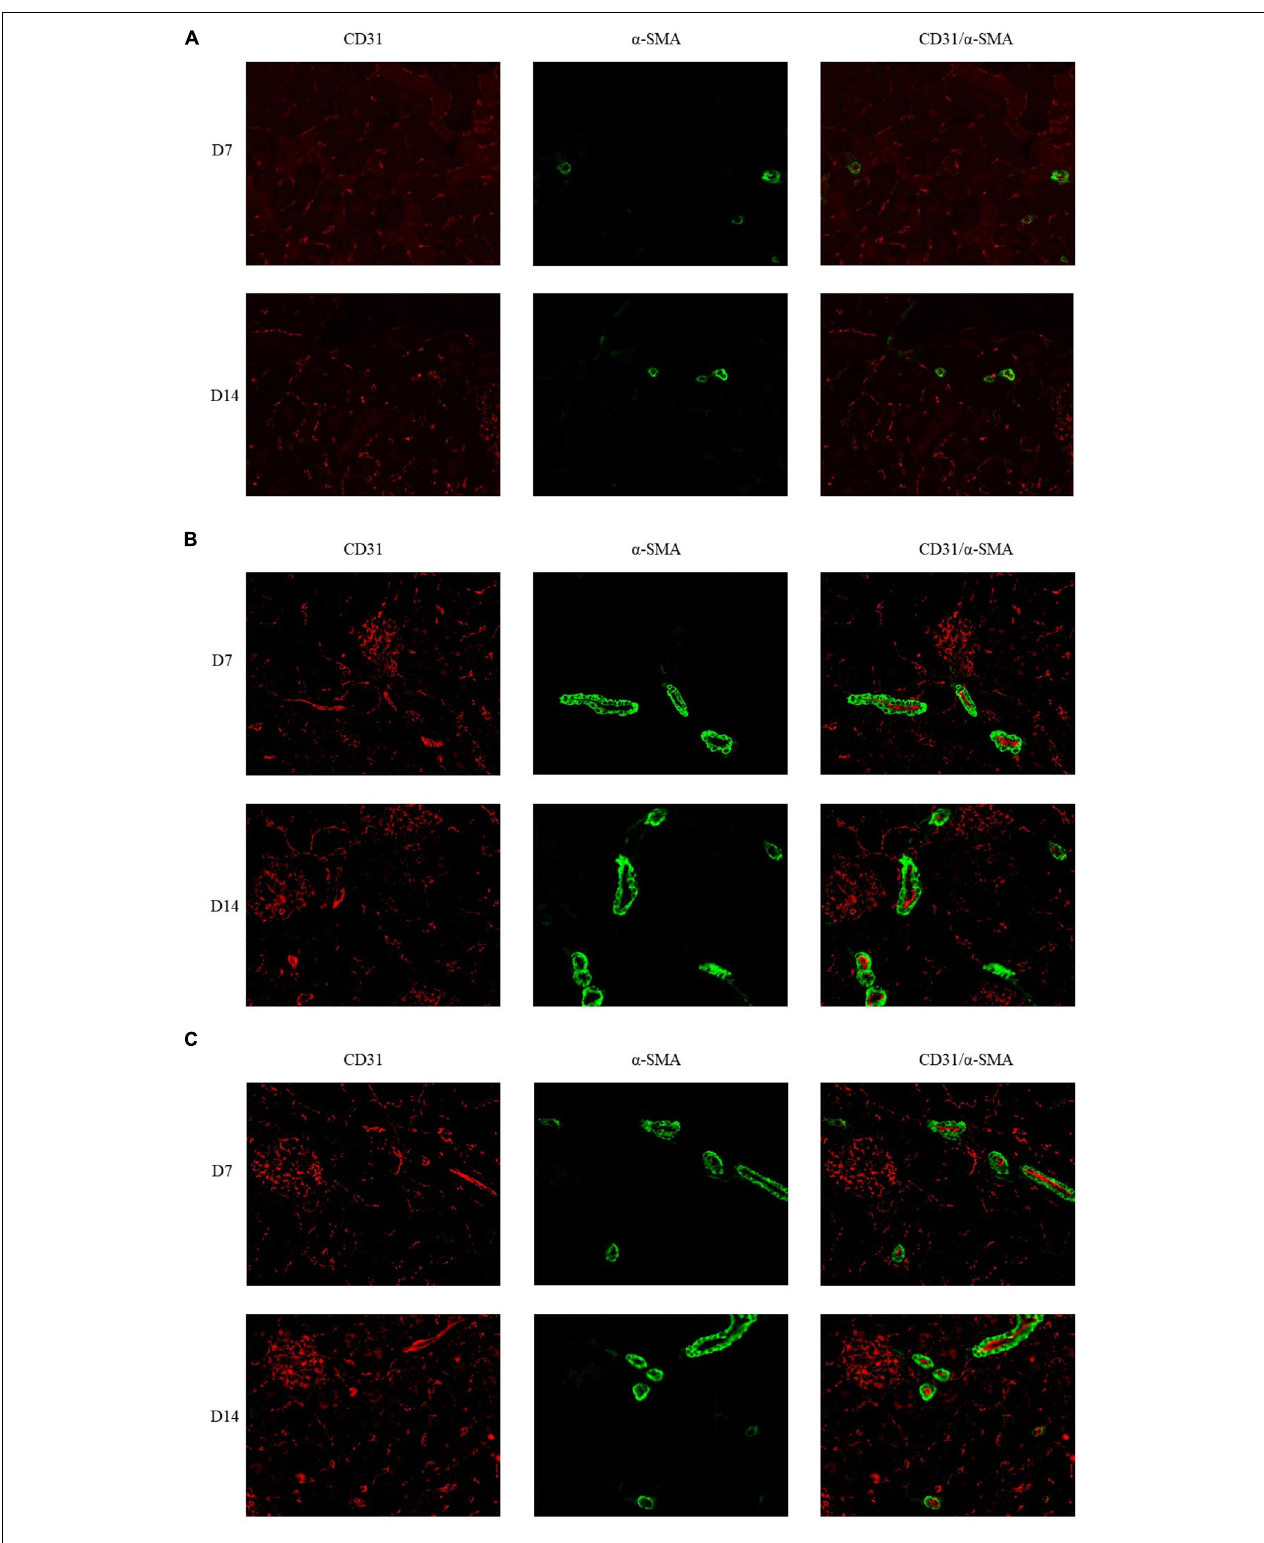
FIGURE 7 | Double immunofluorescence labeling of CD31 (red) and α -SMA (green) in rat kidneys; nuclei are stained with DAPI (blue). (A) Mature blood vessel density of rats in the 21% O 2 group. (B) Mature blood vessel density of rats in the 10% O 2 group. (C) Mature blood vessel density of rats in the 7% O 2 group. Original magnification: ×